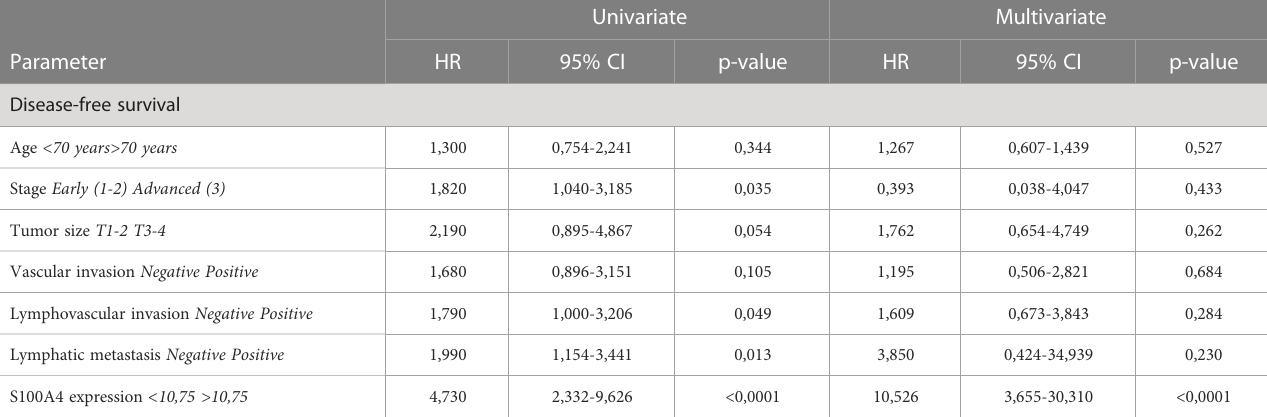
TABLE 2 The prognostic signi fi cance of S100A4 mRNA levels for disease-free survival with colon cancer revealed by univariate and multivariate COX analysis.